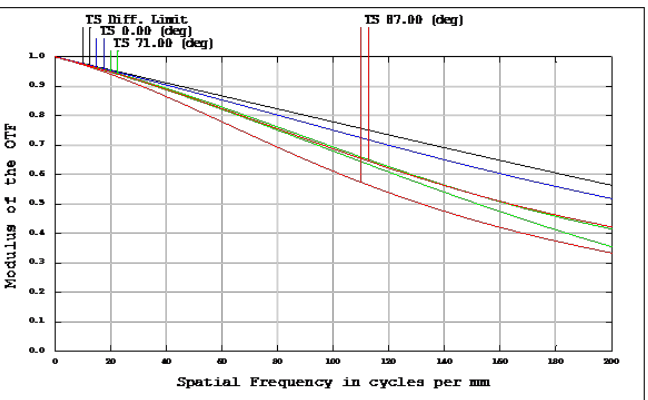
Figure 13. Modulation transfer function (MTF) of wide-angle fisheye lenses using a polymethyl